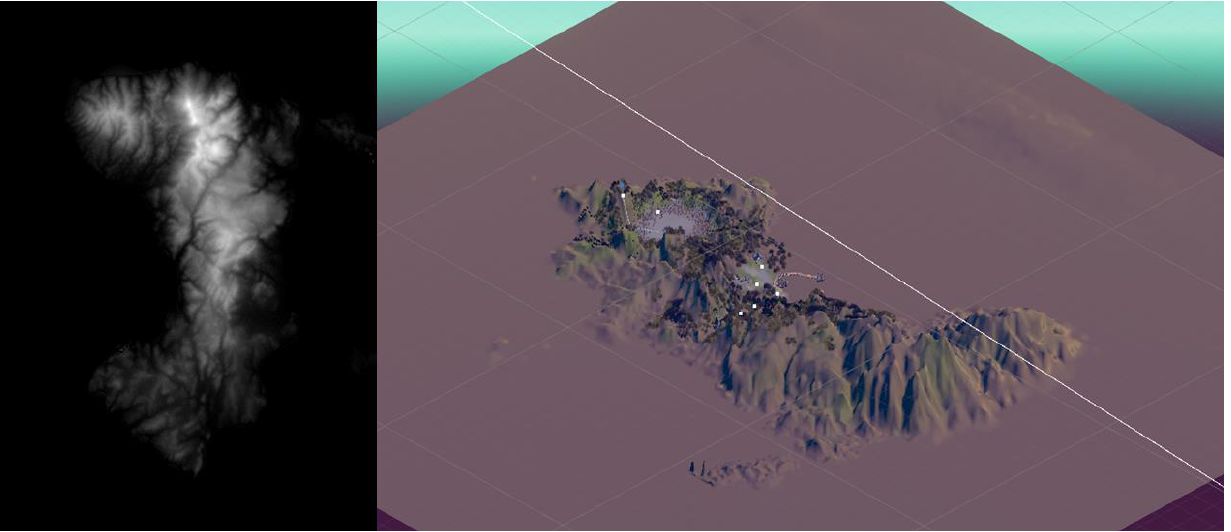
Figure 5. Source heightmap and the final painted terrain.